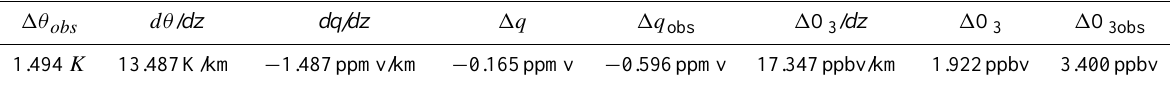
Fig. 5. The contour of temperature versus water vapor frequency from MLS. Dash-dot line shows the saturation line with respect to ice. Upper plots are Northern Hemisphere winter (NW; December 2008 to January 2009), and lower plots Northern Hemisphere summer (NS; June to August 2008).